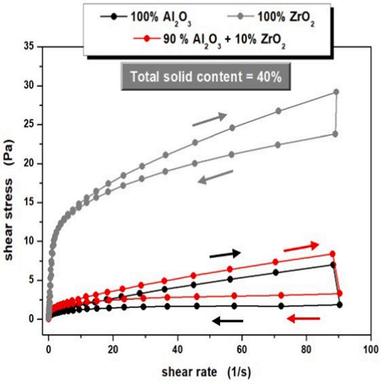
Flow curves of casting slips containing 40 vol.%of solid phase.